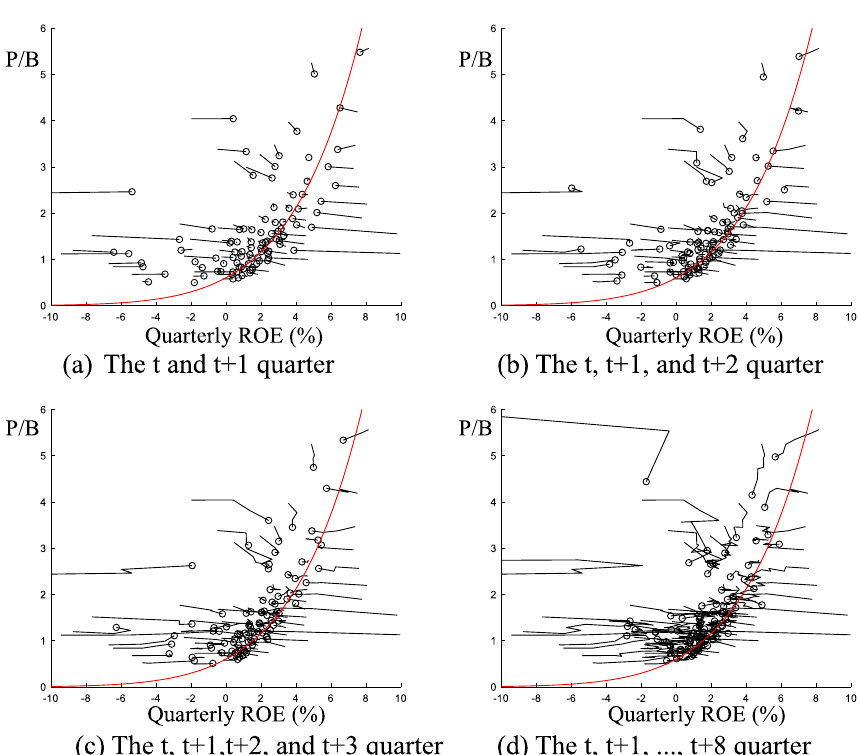
Fig. 17 The movement path of ROE (X axis) and P/B (Y axis) in the current quarter and the subsequent 1, 2, 3, and 8 quarters: large‑cap